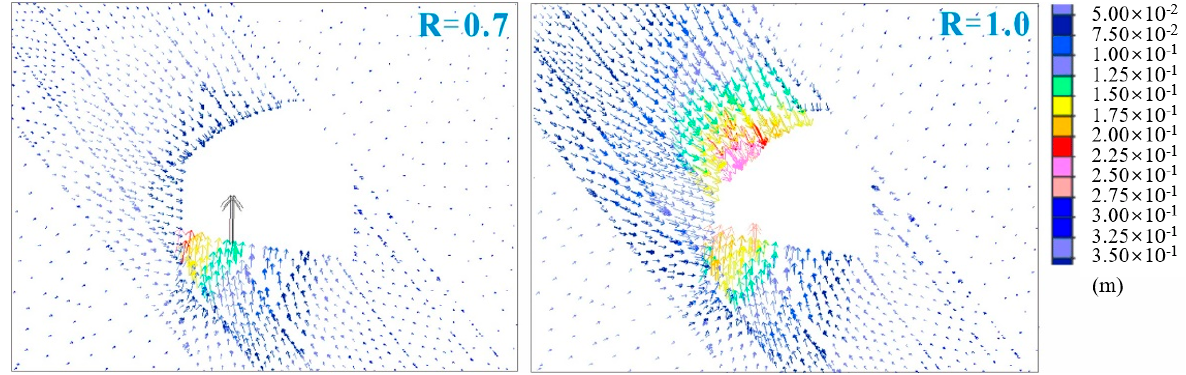
Processes 2023 , 11 , x FOR PEER REVIEW Figure 8. Vector diagram of the displacement field of the roadway. Figure 8. Vector diagram of the displacement field of the roadway.